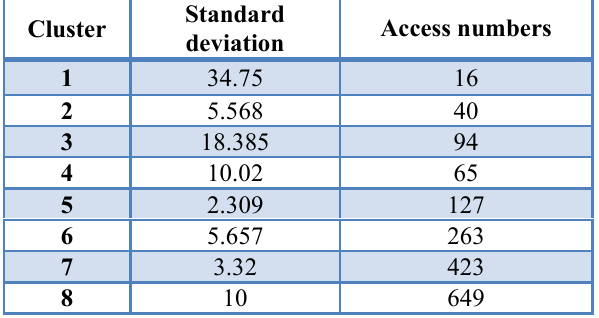
Table 11. Kohonen standard deviation